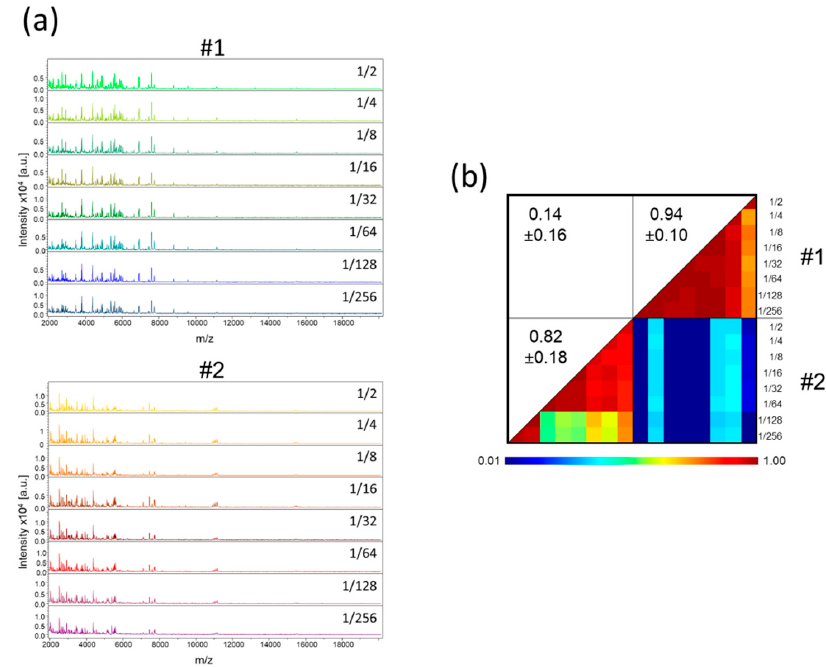
Figure 2. MS profiles of serial dilution of saliva from healthcare workers. ( a ) Representative MS spectra of serial dilution of saliva, collected in plastic tube, prepared according to protocol B from two individuals. The dilution rate is indicated at the right part of each profile. ( b ) Composite correlation index (CCI) matrix representing the levels of MS spectra reproducibility between saliva samples. CCI are expressed as the mean ± standard deviation. #1 and #2: healthcare workers.